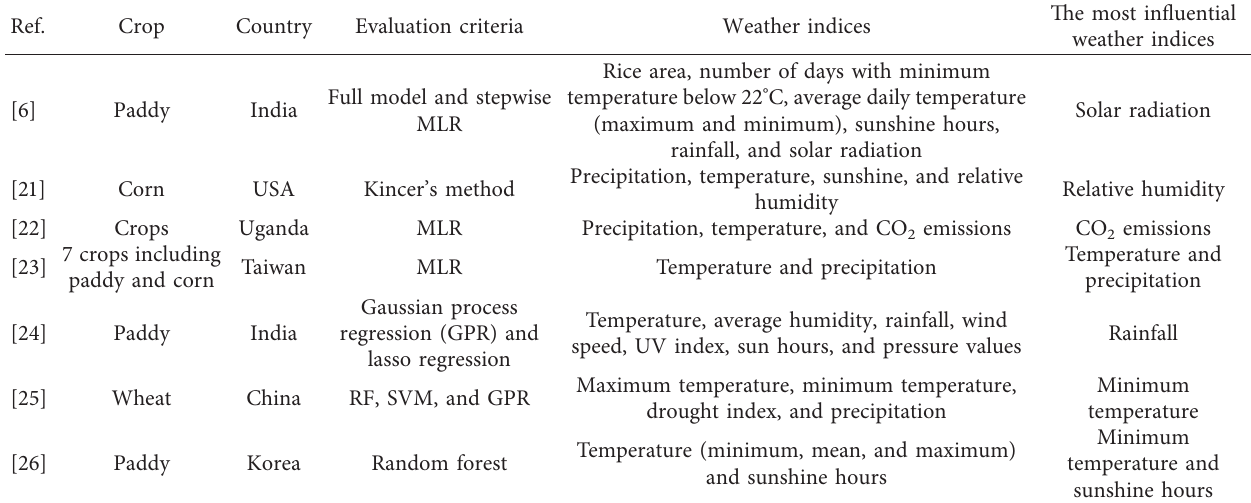
Table 7: Crop-weather